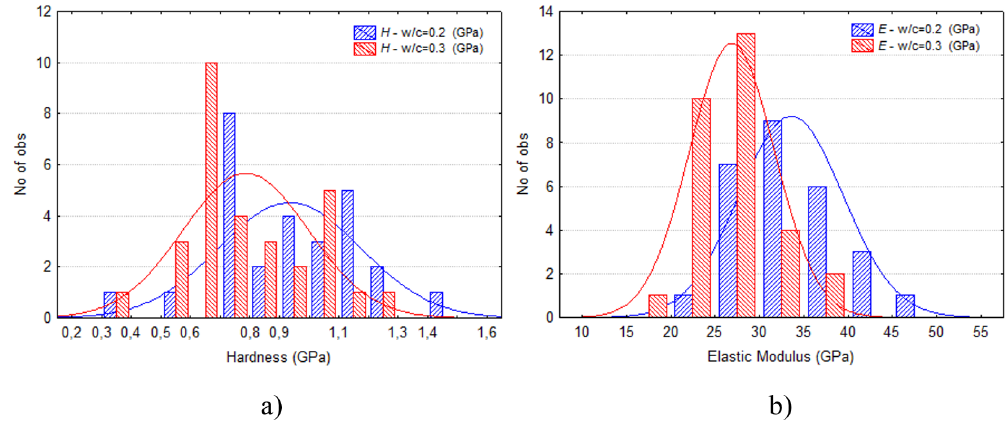
Figure 3. Histogram showing the effect of the w/c ratio on the hardness (a) and elastic modulus